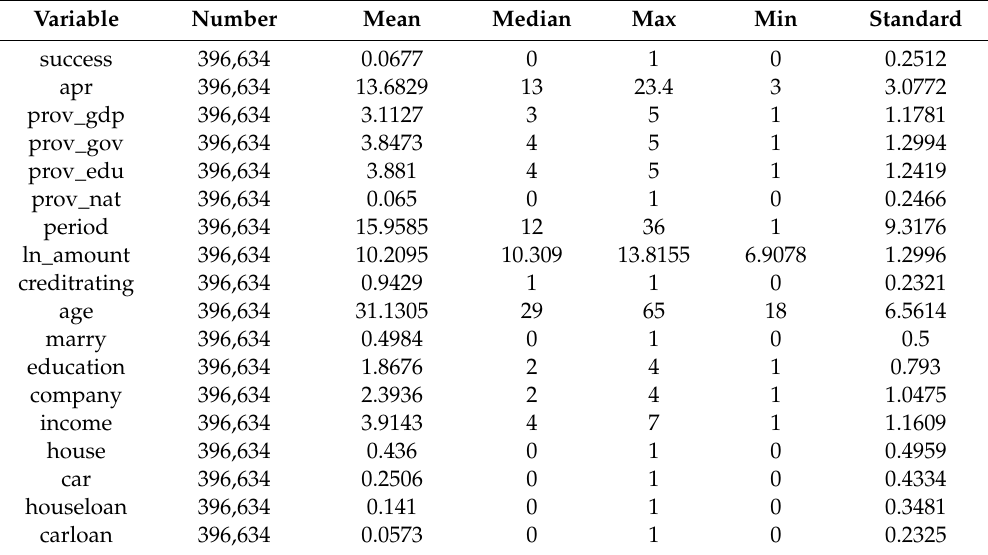
Table 3. Descriptive statistics of